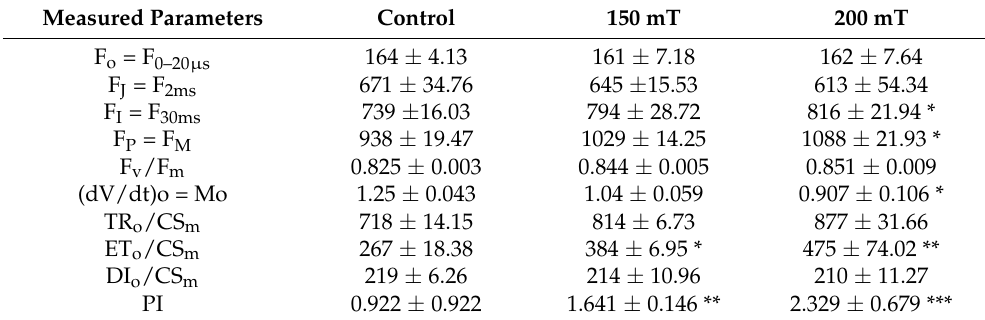
Figure 7. Changes in polyphasic chlorophyll a fluorescence (OJIP) transient curves in soybean leaves after pre-sowing magnetic field treatment of seeds with strengths of 150 and 200 mT for 60 min (O-J-I-P are fluorescence yield at 20 µ s, 2 ms, 30 ms, and maximum fluorescence, respectively). Table 1. Summary of parameters and their description using data extracted from the fluorescence transient OJIP for soybean after magnetic field treatment.